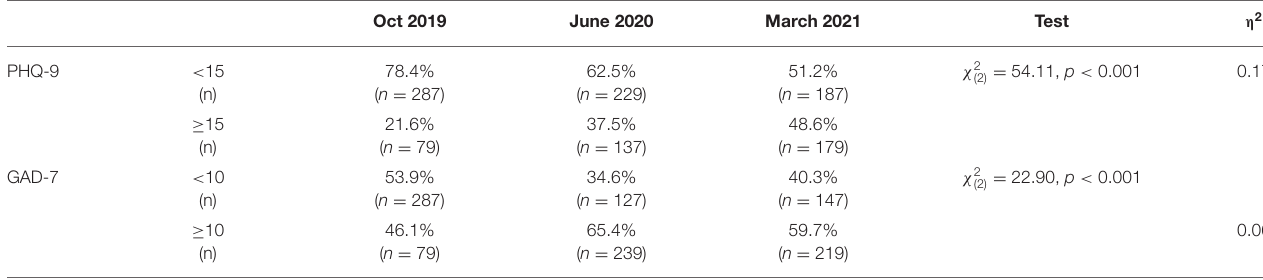
TABLE 1 | Depressive and anxiety symptomatology changes across